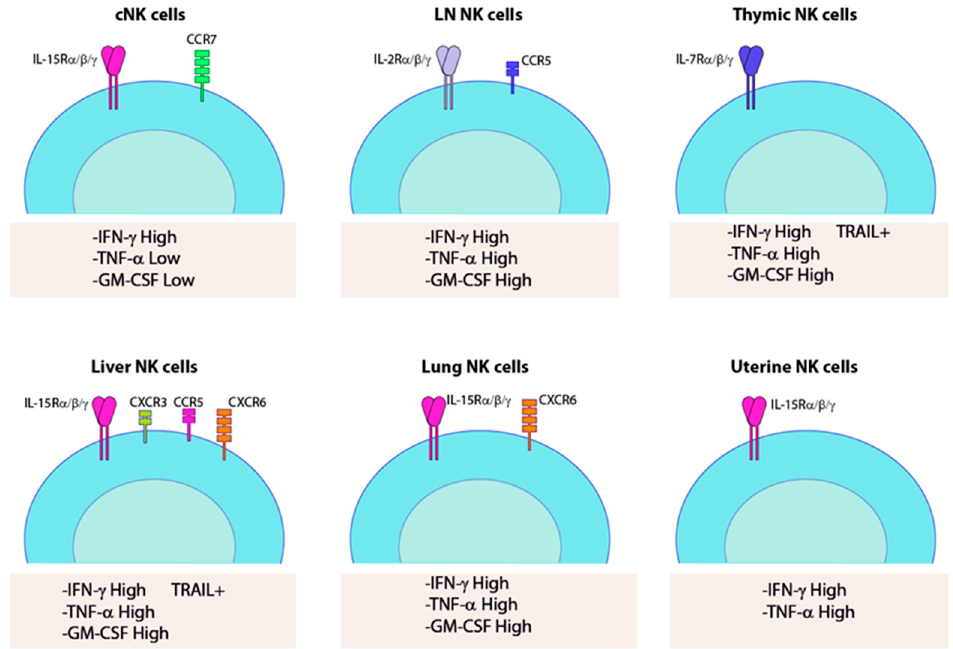
Figure 3. Inflammatory cytokine production from trNK cells. Cytokines produced from each type of trNK cells are shown along with the major cytokine and chemokine receptors.